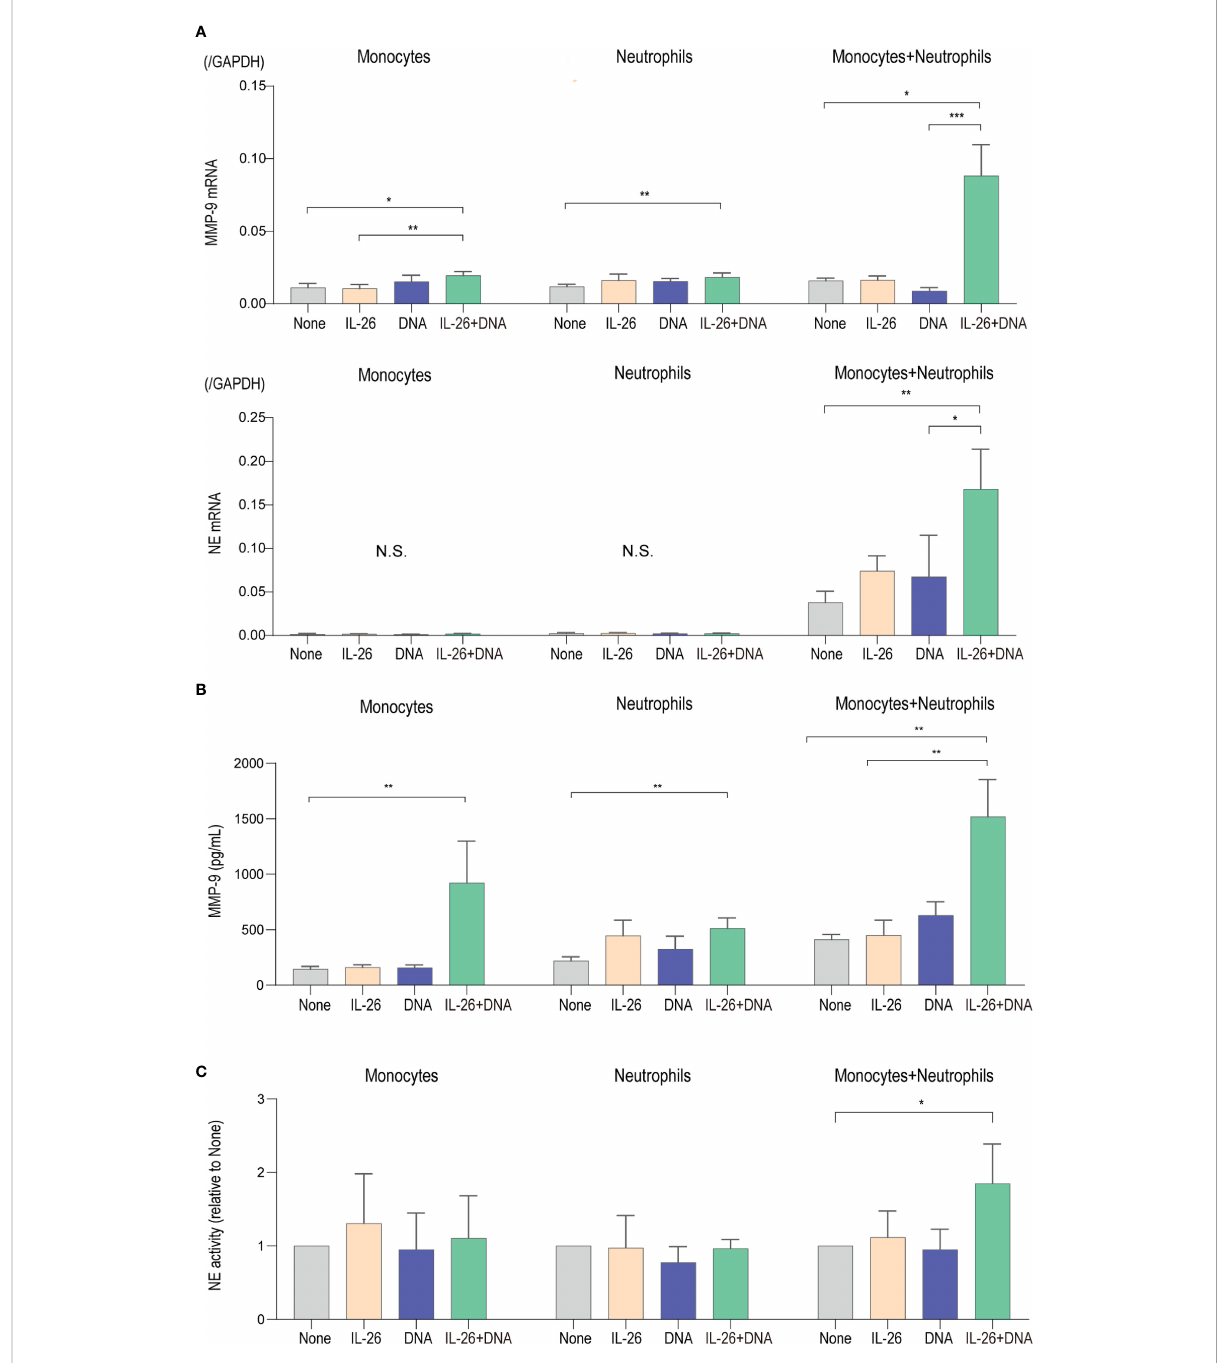
FIGURE 5 IL-26 synergizes with DNA in enhancing the production and activity of proteases (A) Gene expression levels in monocytes alone, neutrophils alone, and co-cultured monocytes and neutrophils. Cells were stimulated with/without 50 ng/L of IL-26 and 10 µg/mL genomic DNA or with IL-26 – DNA complexes for 6 hours. The relative mRNA expressions of MMP-9 and NE were evaluated by quantitative real-time PCR. Results shown are representative of fi ve independent experiments with similar results. Data are presented as mean ± SD. * p < 0.05 ** p < 0.001 *** p < 0.0001. N.S., Not signi fi cant. (B) Protein levels of MMP-9 and (C) NE activities of supernatants from monocytes alone, neutrophils alone, and co-cultured monocytes and neutrophils. NE activity scores are presented relative to none. Data are presented as mean ± SD. * p < 0.05 ** p < 0.001 *** p < 0.0001. N.S., Not signi fi